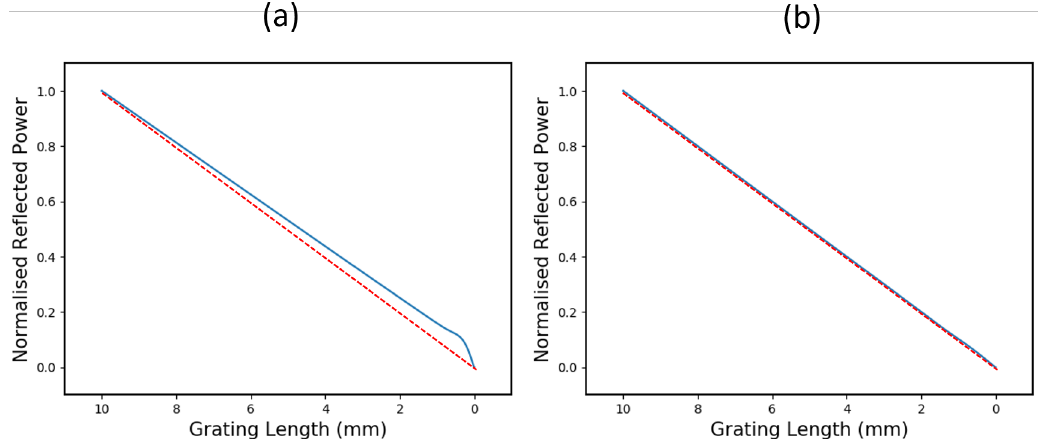
Figure 5. ( a ) A plot of the characteristic reflected power scaling for a 10 mm long, 20 nm bandwidth, 99% reflectivity CFBG. ( b ) A plot of the characteristic reflected power scaling for a 10 mm long, 10 nm bandwidth, 20% reflectivity